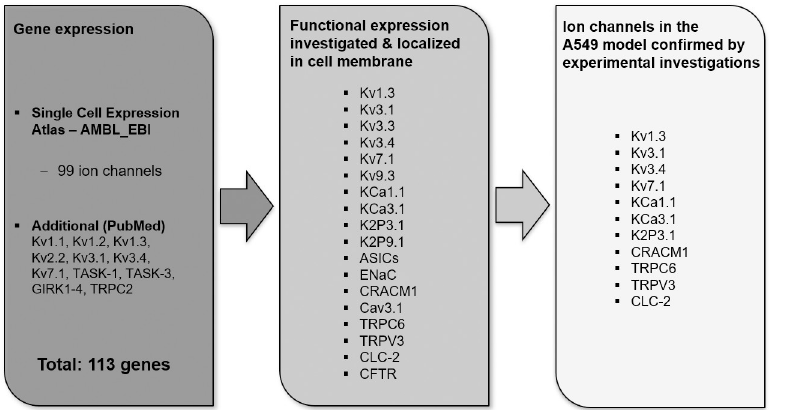
Fig 1. Reported ion channels in the A549 cell line. For detailed review see S1